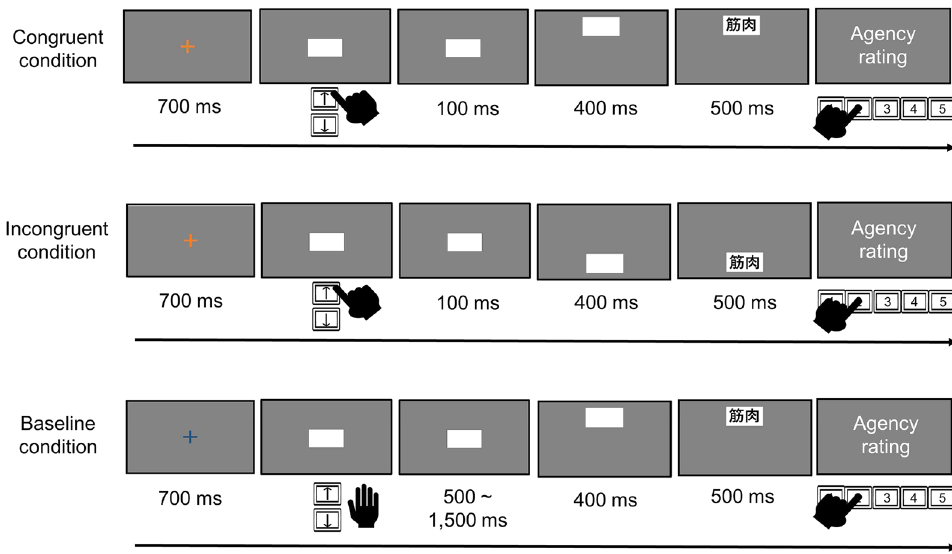
Figure 1. Schematic illustration of the agency task in Experiment